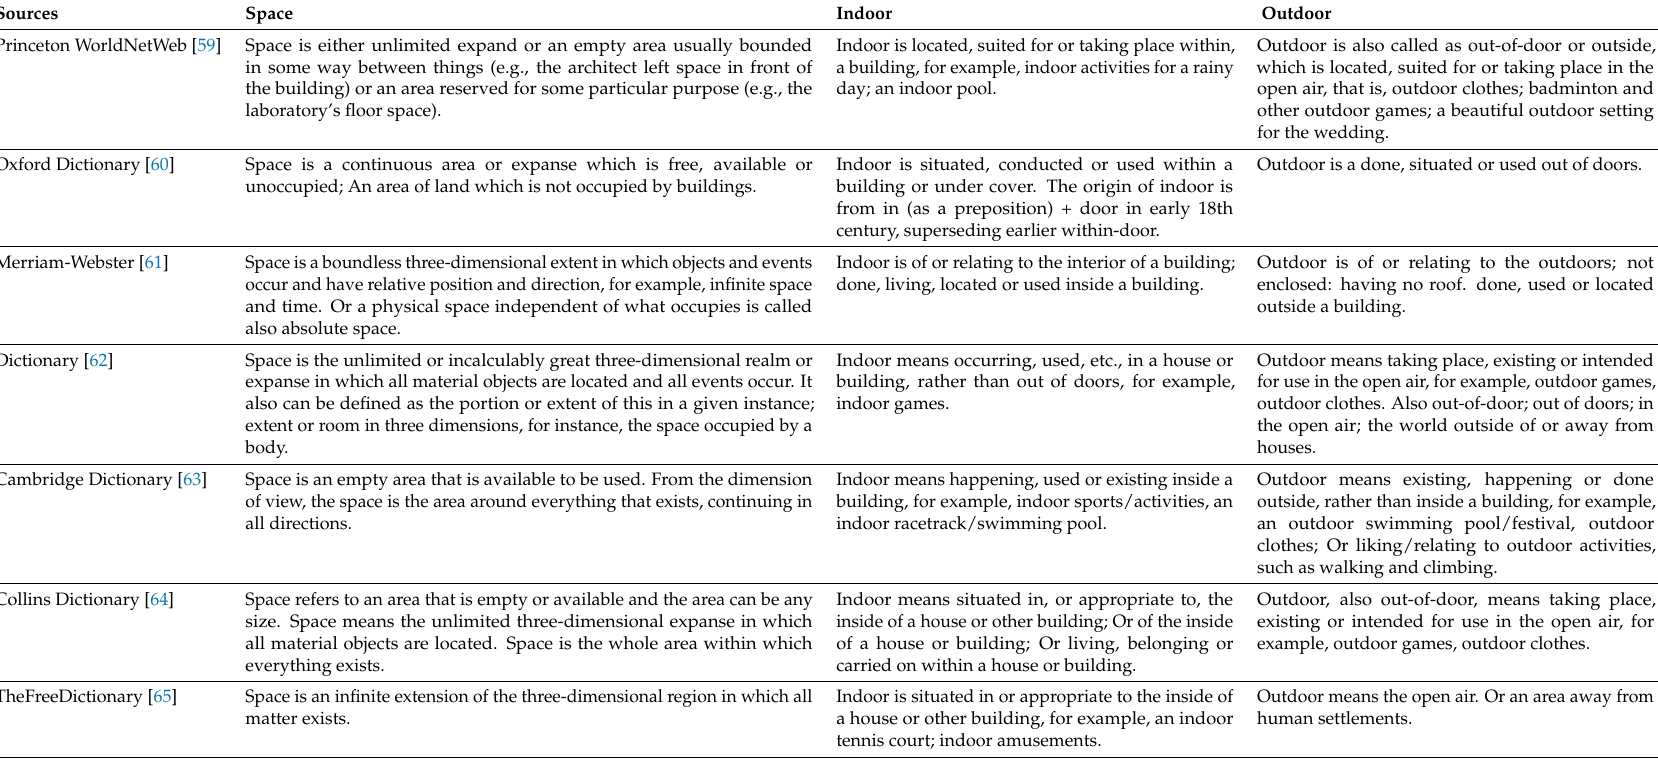
Table 1. The definitions of Space, Indoor and Outdoor from different